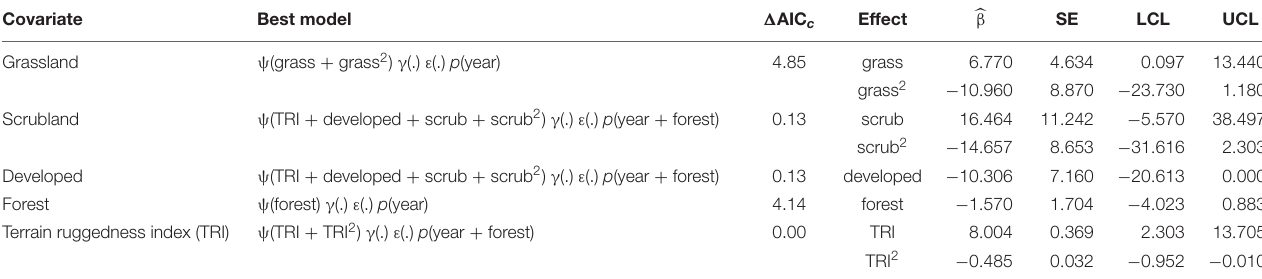
TABLE 2 | Best model containing the effect of each landscape covariate on site occupancy ( ψ ) of territorial pairs of golden eagles in coastal southern California, United States, 2016 – 2017. Covariate Best model